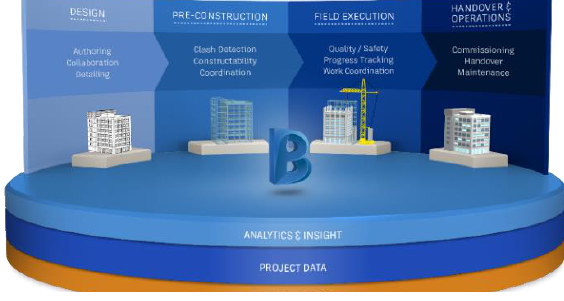
Figure 6: BIM 360